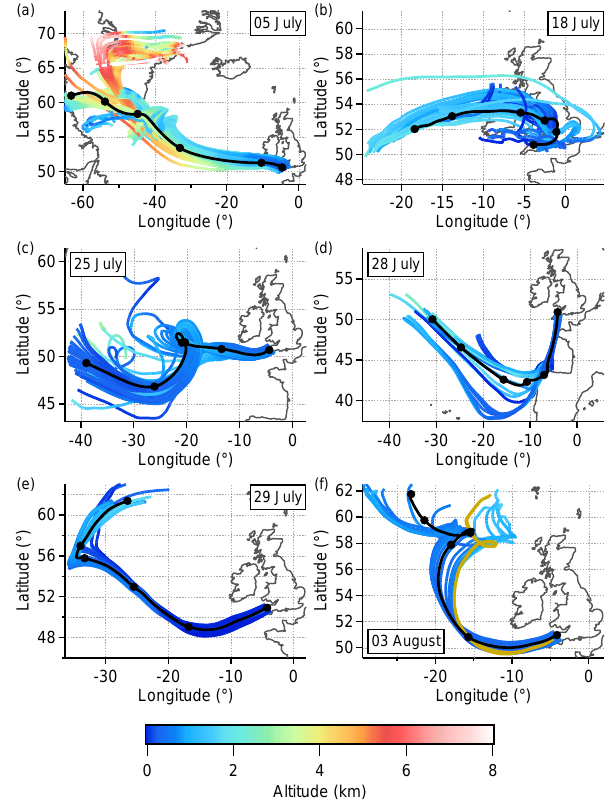
Figure 1. Five-day HYSPLIT back trajectories initiated over the southwest peninsula of the UK during the boundary layer aerosol runs. Panels (a – f) show the back trajectories on different flying days. Individual trajectories are coloured by altitude. The black lines show the mean trajectories, with markers every 24h before sampling. The two gold lines in (f) (which lie approximately on top of each other on the plot) are the two trajectories released from the ground site at 11:00 and 12:00UTC. The altitude of these two tra- jectories remained below 200m in the first 48h, and below 1000m in the 120h of the